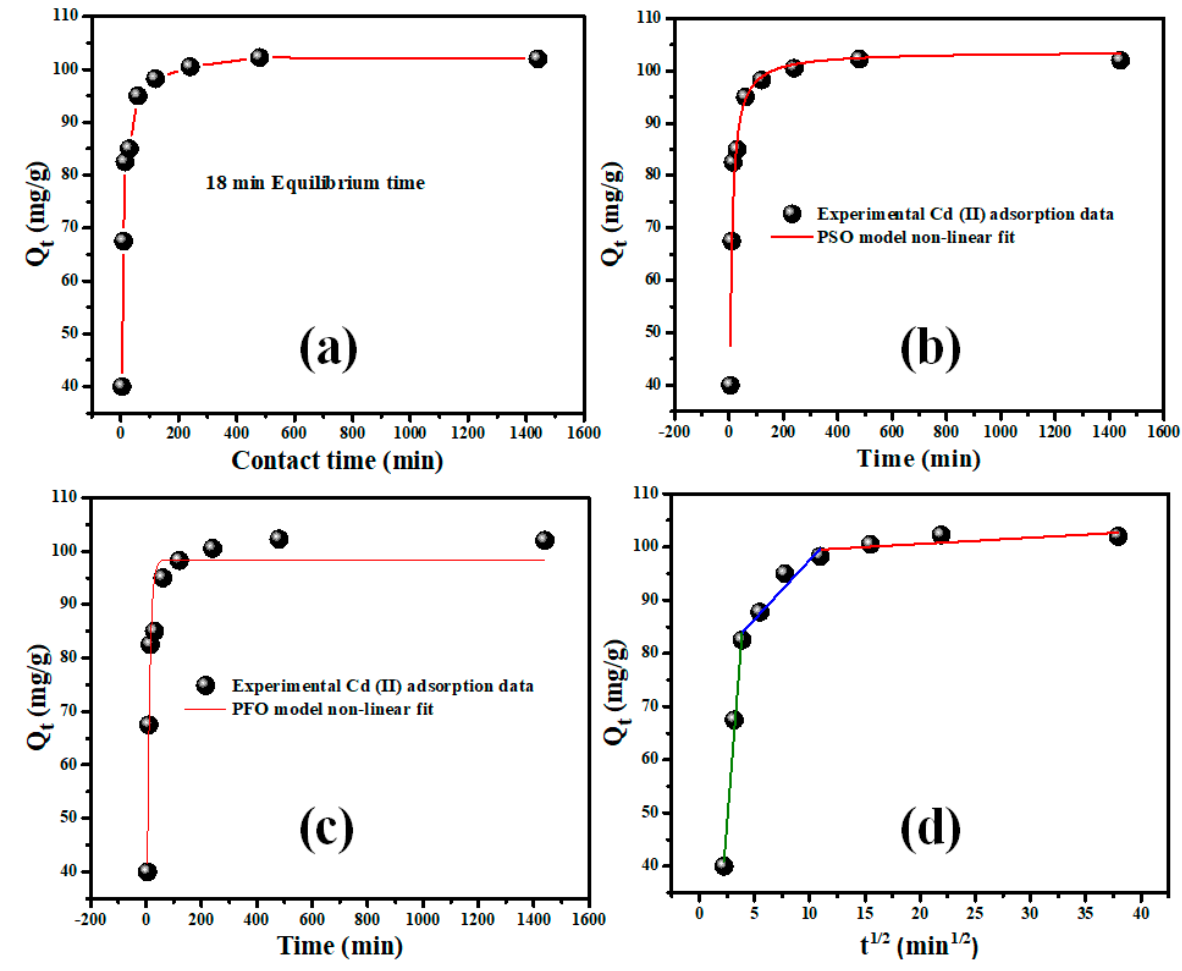
Figure 9. ( a ) Contact time, ( b ) PFO ( c ) PSO kinetics and ( d ) IPD models for Cd (II) adsorption ( c ). To study the Cd ions adsorption rate, two well-known kinetic models were used to comprehend the kinetics of Cd ion adsorption on Ru-ZnO-g-C 3 N 4 nanocomposite. The non-linearized versions of the pseudo-first-order [35] (Equation (1)) and pseudo-second- order [36] (Equation (2)) kinetic models are as follows: